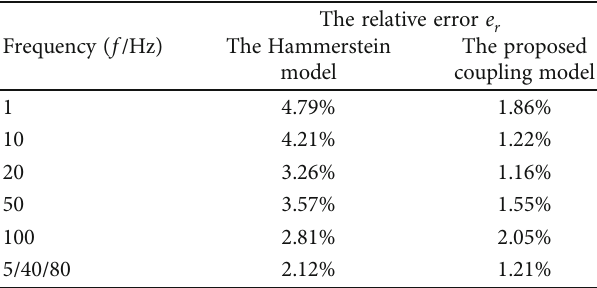
Table 3: The relative error of the Hammerstein model and the proposed coupling